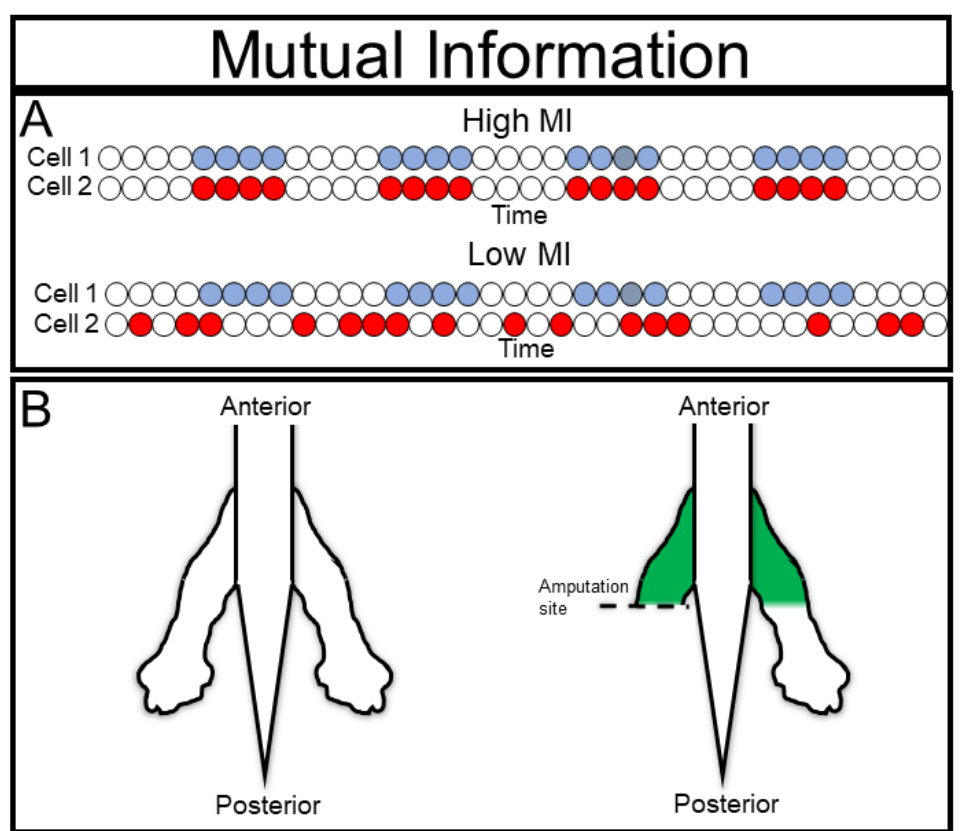
Figure 4. Mutual Information: ( A ) Mutual information measures the information that knowing the state of one variable provides about a second variable; ( B ) mutual information can be used to detect novel communication channels, as in the case of contralateral bioelectric injury signals. Redrawn with permission after [26] ; 2018, The Company of Biologists Ltd.